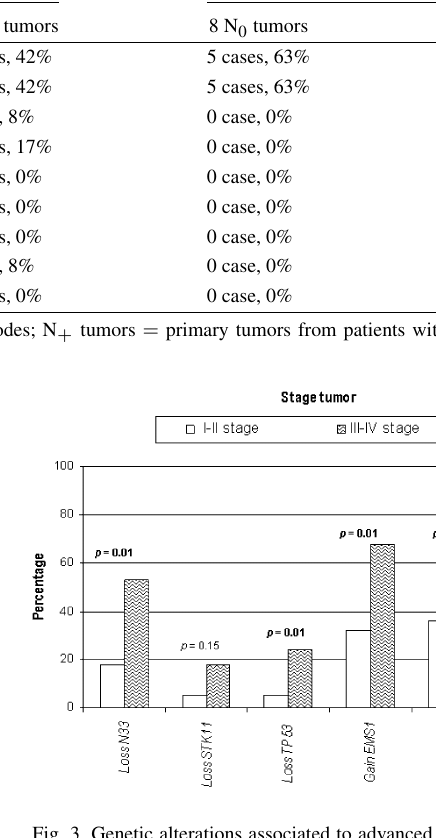
Fig. 3. Genetic alterations associated to advanced stage (III and IV stage) from larynx and pharynx tumors detected by MLPA. (Amp: